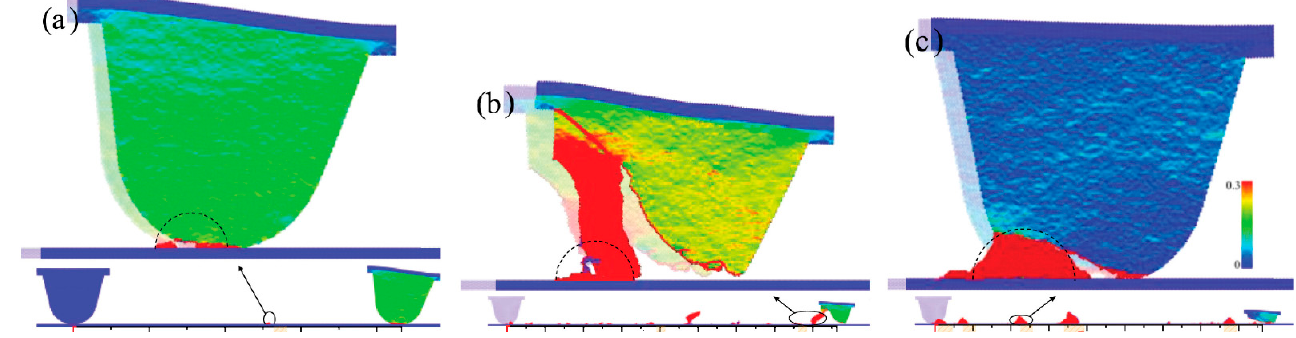
Figure 4. Three observed wear mechanisms: ( a ) atomic cluster detachment; ( b ) cleavage fracture; ( c ) plasticity. The black dashed lines show the size of contact area corresponding to wear volume hypothesized in Archard’s model. Taken from [61].